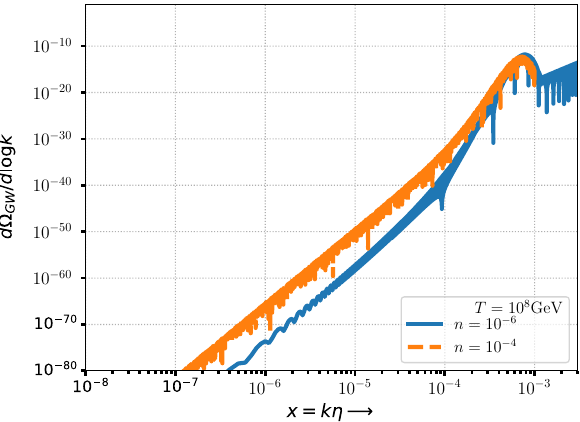
Fig. 2 Gravitational wave spectrum as a function of x = k η at differ- ent number densities at temperature T ∼ 10 8 GeV. For a large number density, the effects at large length scale is more than at the small length